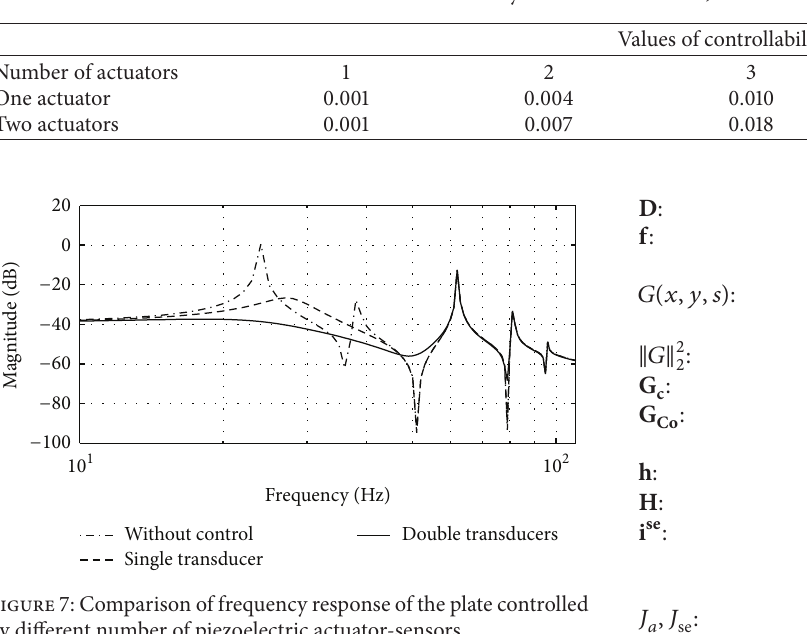
Figure 7: Comparison of frequency response of the plate controlled by different number of piezoelectric